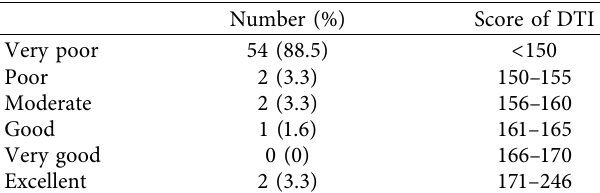
Table 6: DTI scores of students in different domains by